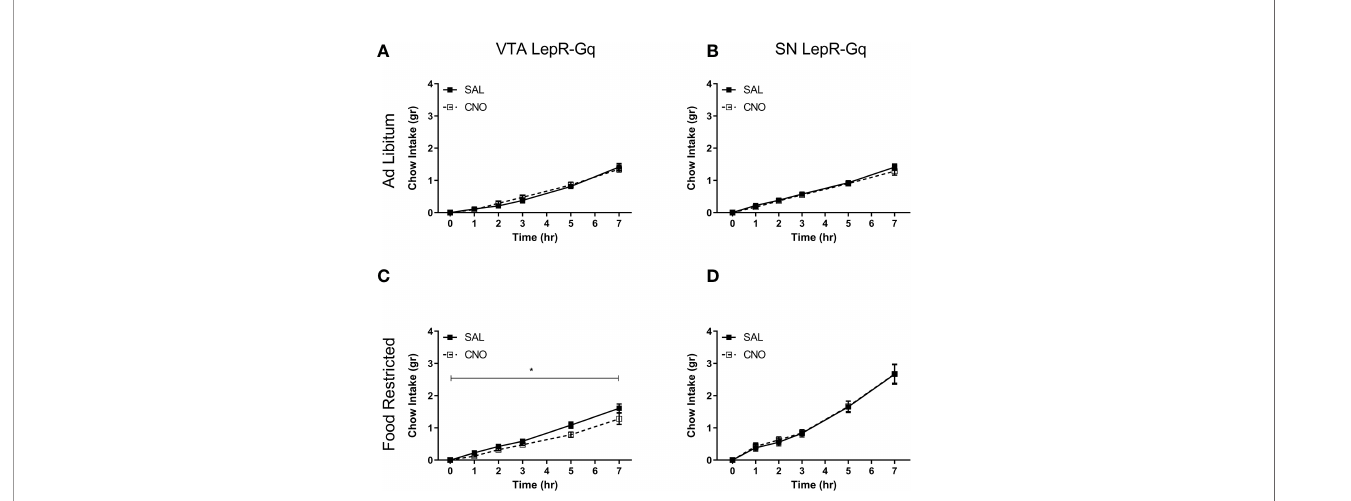
FIGURE 7 | Consumption of chow upon chemogenetic activation of VTA LepR or SN LepR neurons. Chow intake was not affected by CNO (1.0mg/kg) injections in ad libitum fed (A) VTA LepR-Gq (n=6) or (B) SN LepR-Gq mice (n=6). (C) CNO decreased cumulative chow intake in food restricted VTA LepR-Gq mice (n=6). (D) CNO did not affect feeding in food restricted SN LepR-Gq mice (n=6). Mean ± SEM.